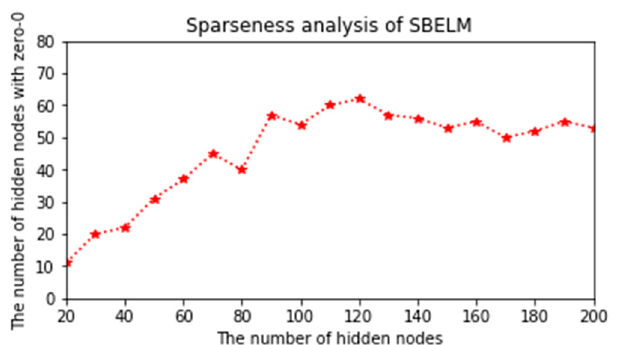
Figure 7. Number of non-zero-weight hidden nodes of the SBELM-based model.